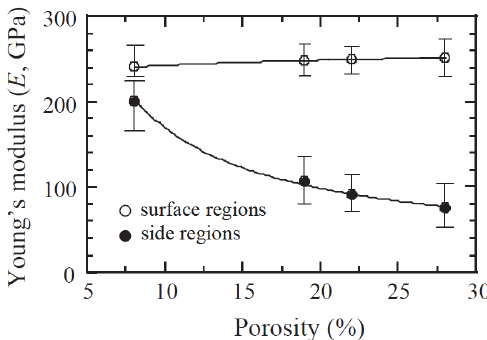
Figure 16. Young’s modulus as function of porosity for ZrO 2 -4 mol% Y 2 O 3 coatings (reproduced with permission from [76], Elsevier, 2005).